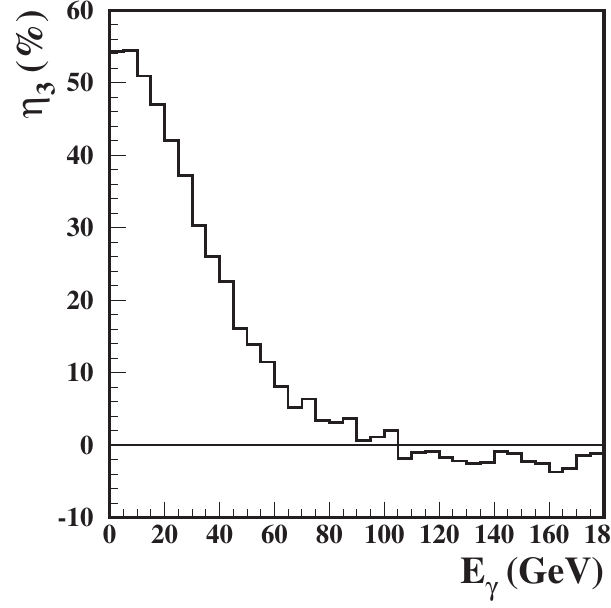
FIG. 24. (Color) Enhancement of the intensity with respect to the Bethe-Heitler (ICB) prediction for randomly oriented poly- crystalline Si as a function of the total radiated energy E SOS-aligned Si crystal by 178 GeV electrons. The black crosses are the measurements and the red histogram represents the Monte Carlo